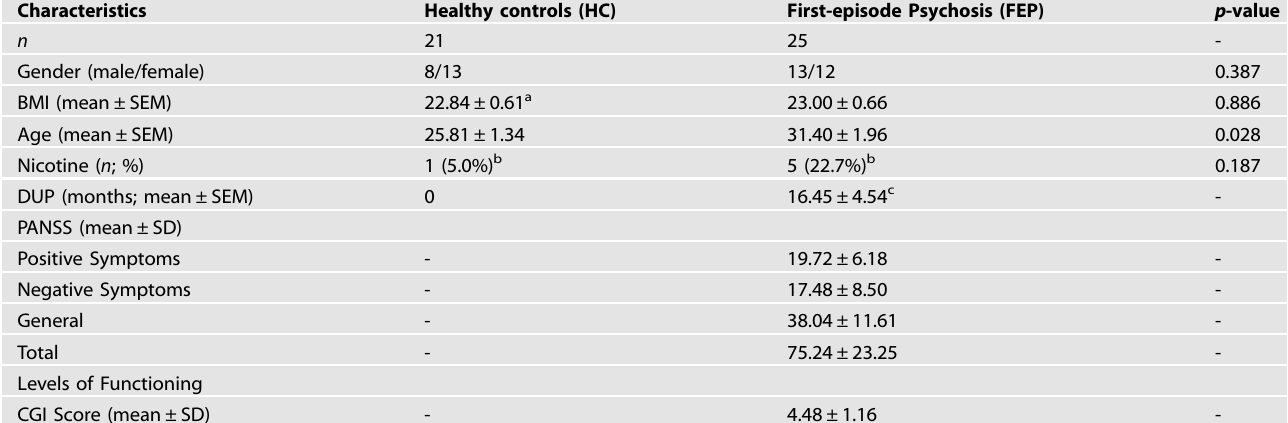
Table 1. Baseline subject demographics and clinical characteristics for untargeted